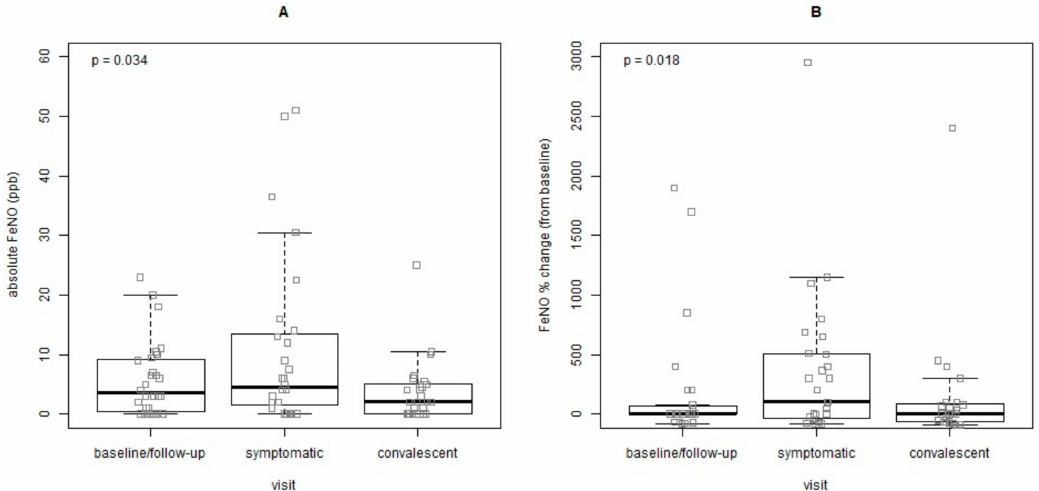
Figure 2. Variations in FeNO measurements from healthy state (baseline / follow-up) to the subsequent exacerbation and convalescence periods in preschool-aged children with recurrent wheeze / asthma. ( A ) Comparison of absolute FeNO values, ( B ) Comparison of FeNO % change.